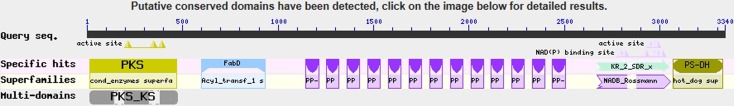
Conservative domains of amino acids of PKS3, including 3-ketoacyl synthetase enzyme domain (KS), acyltransferase enzyme domain (FabD), 3-ketoacyl-ACP reductase enzyme domain (KR), dehydratase enzyme domain (DH) and thirteen phosphopantetheine-binding sites (pp-binding site).